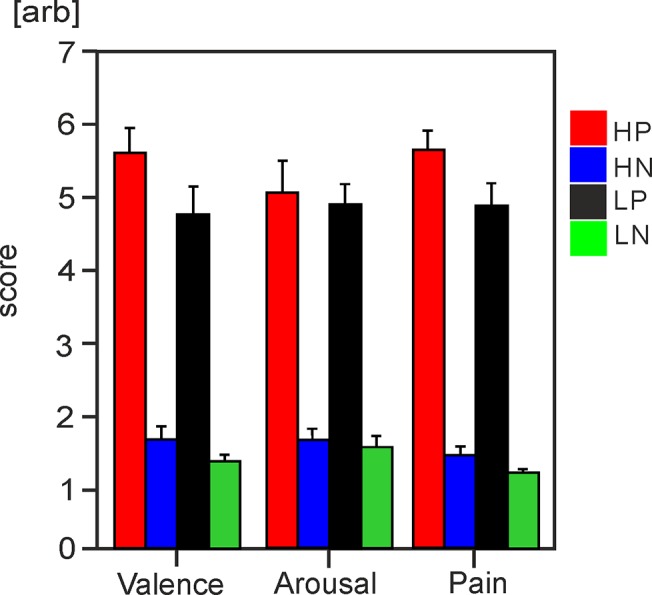
Self-report picture ratings.Bar charts with standard error bars illustrate mean values for ratings of affective valence, arousal and pain in High-Cat and Low-Cat groups for both types of pictures. HP = High-Cat pain pictures, HN = High-Cat non-pain, LP = Low-Cat pain pictures, LN = Low-Cat non-pain.